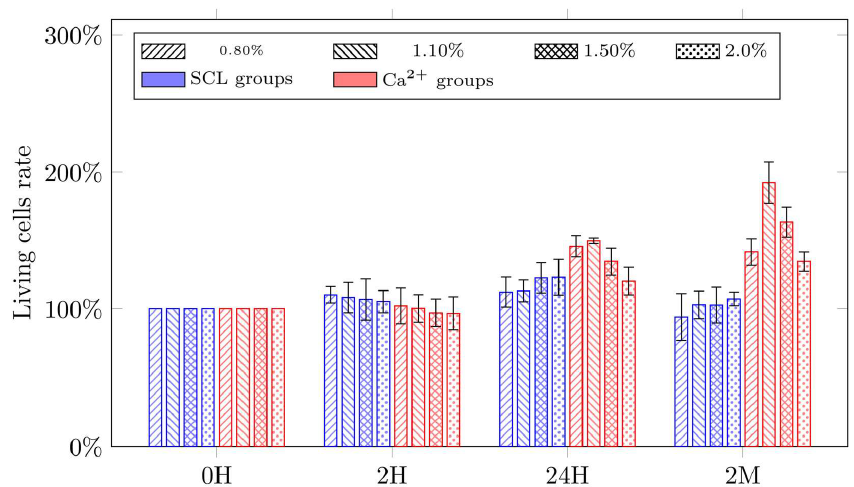
Figure 4. Living cell rates in SCL and Ca 2+ hydrogels at different time intervals. 0.8%, 1.1%, 1.5%, and